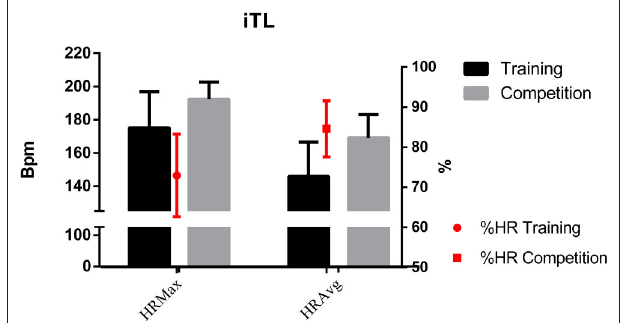
FIGURE 2 | Internal load by game situation.